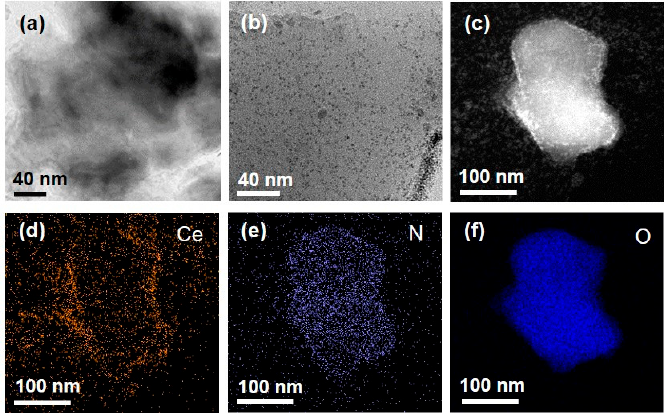
Figure 2. TEM images of ( a ) free agarose gel and ( b ) agarose_nanoceria. ( c ) STEM images of agarose composite entrapping both nanoceria and Gal Ox, and the corresponding EDS maps of ( d ) Ce, ( e ) N, and ( f ) O elements.